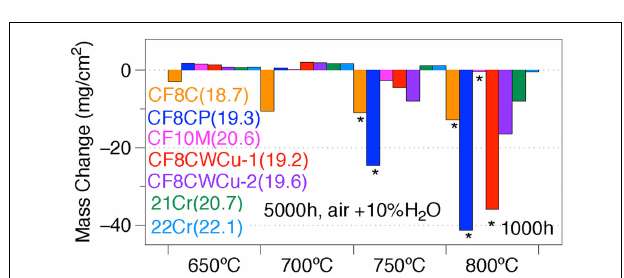
FIGURE 15 | Specimen mass changes for alloys CF8C, CF8CP, CF10M, CF8CWCu-1, CF8CWCu-2, 21Cr–15Ni, and 22Cr–17.5Ni exposed in air +++ 10%H 2 O at 650–800°C for 1000h or 5000h . The Cr content of the alloys is indicated in